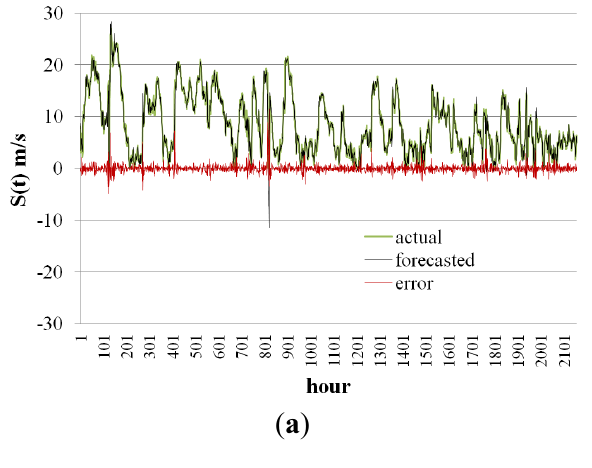
Figure 7. Actual/forecasted wind speeds/powers and errors during the spring: ( a ) S( t ); ( b ) P( t ).